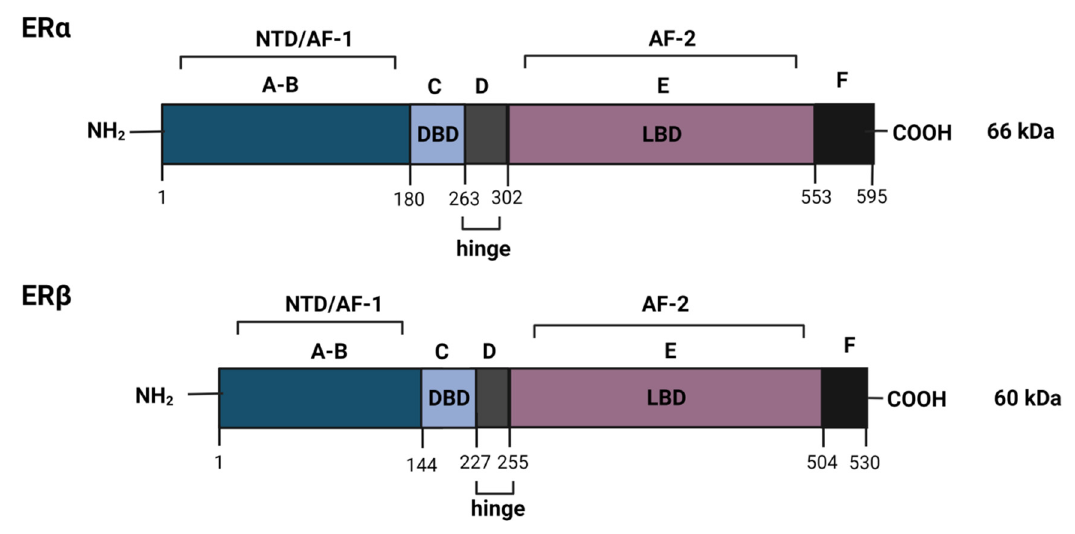
Figure 1. Structural organization of the α and β isoforms of the estrogen receptor (ER). The ER comprises six functional domains: A/B domains, N-terminal domain (NTD, containing activation function 1; C domain, the DNA-binding domain (DBD); D domain, hinge domain containing nuclear localization signals; E domain, ligand-binding domain (LBD) containing activation function 2; F domain, regulatory